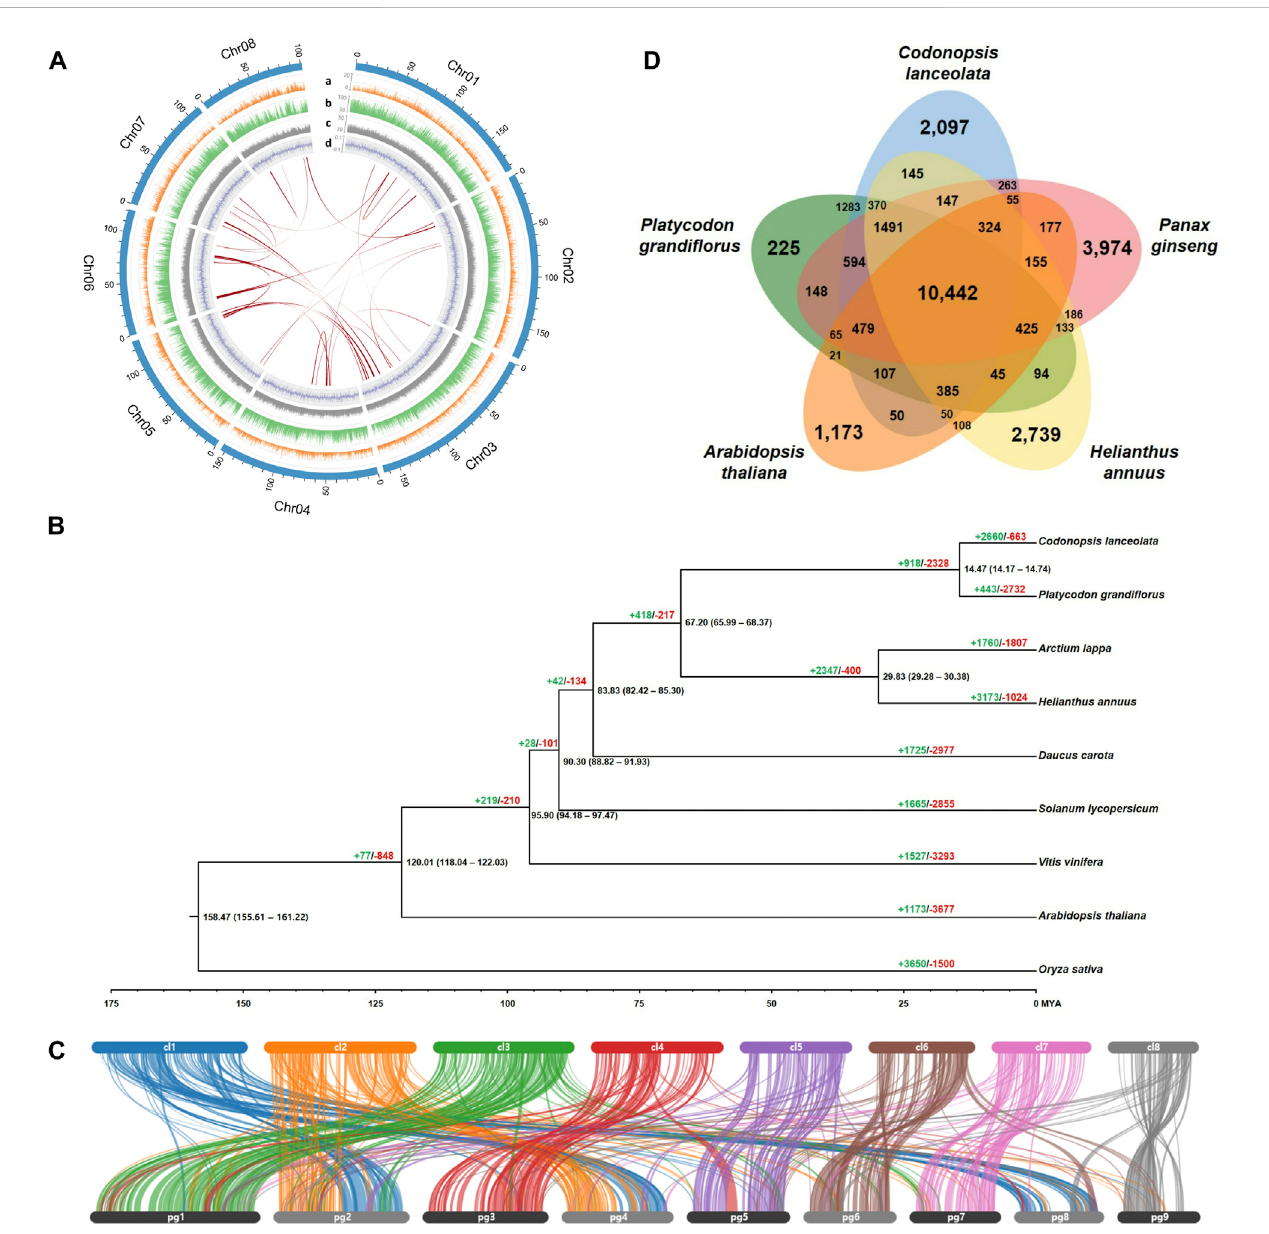
FIGURE 1 C. lanceolata genome characteristics, phylogenomics, synteny structure, and gene clusters. (A) Circos plot representing the eight pseudo- chromosomes in the C. lanceolata assembly and their features. The outermosttrack (light blue) indicates eight pseudo-chromosomes. Tracks a – ddepict the distribution of genes (orange), repeat elements (green), GC contents (gray), and GC skew (blue), respectively. The innermost lines (red) represent collinear blocks identi fi ed within the C. lanceolata genome. (B) Phylogenetic tree and gene family evolution of nine plant species. The black numbers above each node indicate divergence times between groups. The green (+) and red ( − ) numbers indicate the values of expanded and contracted gene families, respectively. (C) Synteny blocks between C. lanceolata and P. grandi fl orus genomes. The upper and lower bars indicate each pseudo-chromosomes of C. lanceolata and P. grandi fl oras , respectively. (D) Shared and unique gene clusters in C. lanceolata and four related